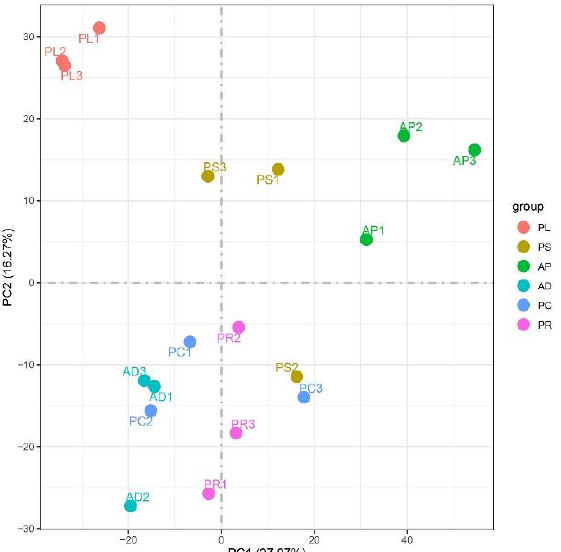
Figure 3. Two-dimensional PCA analysis visualization to measure different host samples. The X- abscissa (PC1) and Y-ordinate (PC2) are the 2 main coordinates with the largest interpretative degree of differences between samples. The same color represents the same grouping. A point is a sample, and similar samples are gathered.